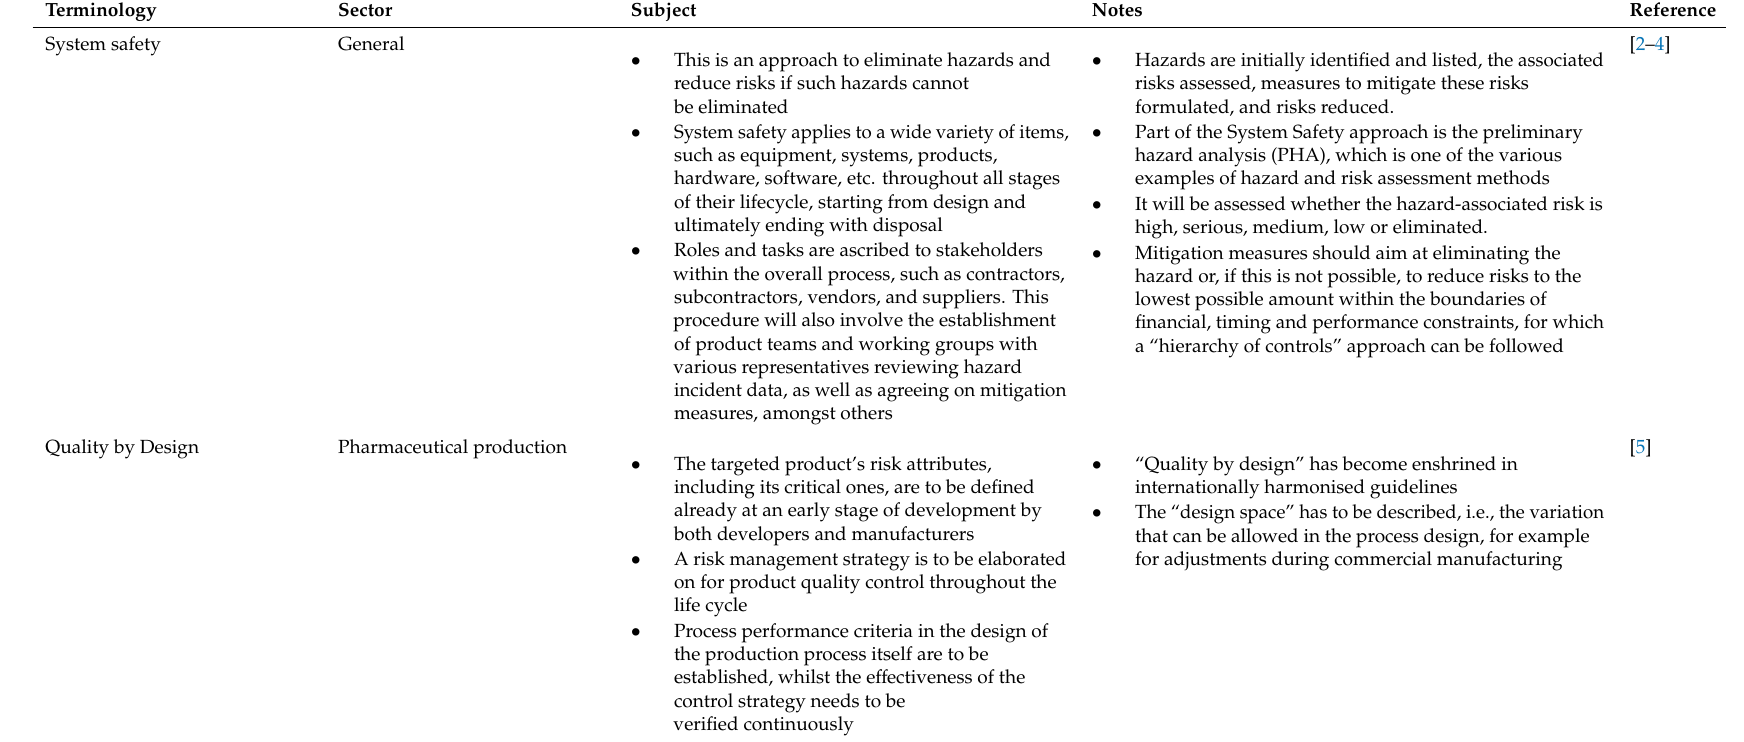
Table A1. Examples of worldwide initiatives to ensure design through early measures during product or process